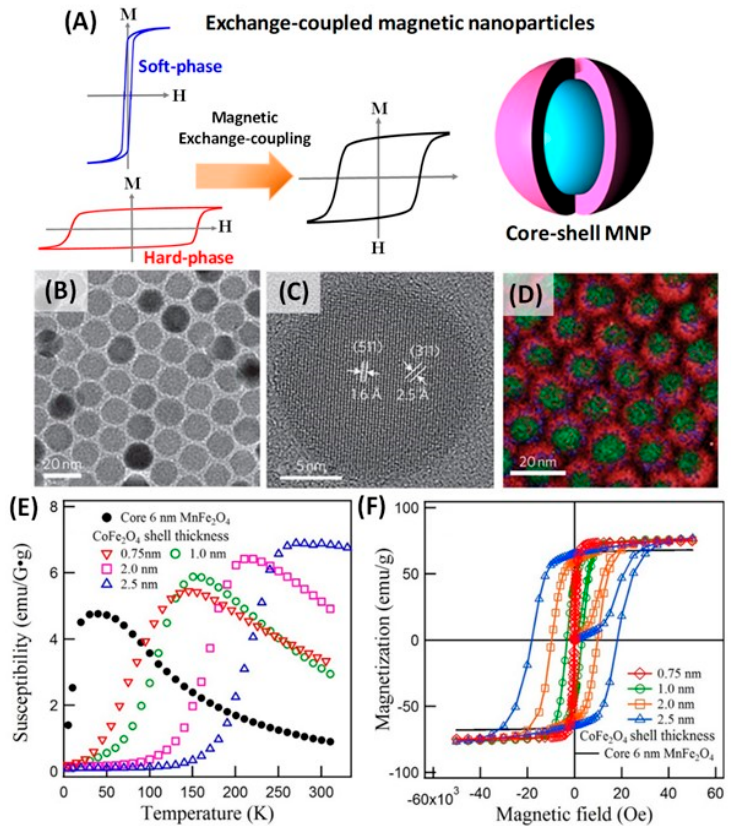
Figure 17. ( A ) A schematic depiction of the hysteresis loops for soft and hard nanoparticles and their possible combinations: exchange-coupled core-shell nanoparticles. ( B ) TEM image, ( C ) high-resolution TEM image of 15 nm CoFe 2 O 4 /MnFe 2 O 4 core–shell NPs and ( D ) Overlay of electron energy-loss spectrum mapped images of Co (green), Fe (red) and Mn (blue) [31]. ( E ) Temperature dependent susceptibility under 100 Oe field and ( F ) hysteresis loops at 5 K for MnFe 2 O 4 /CoFe 2 O 4 core–shell nanoparticles with variation of shell thickness as 0, 0.75, 1.0, 2.0 and 2.5 nm [139].